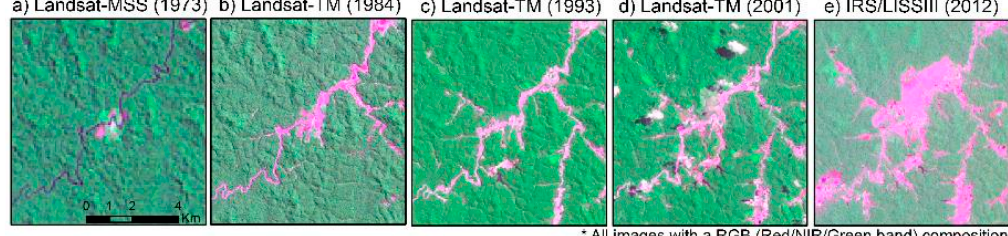
Figure 6. Example of how severe ASGM land changes remains detectable by satellite images. It also illustrates ASGM expansion over the decades from 1973 ( a ); 1984 ( b ); 1993 ( c ); 2001 ( d ); to 2012 ( e ). RGB composition of Landsat and IRS/LISSIII images.